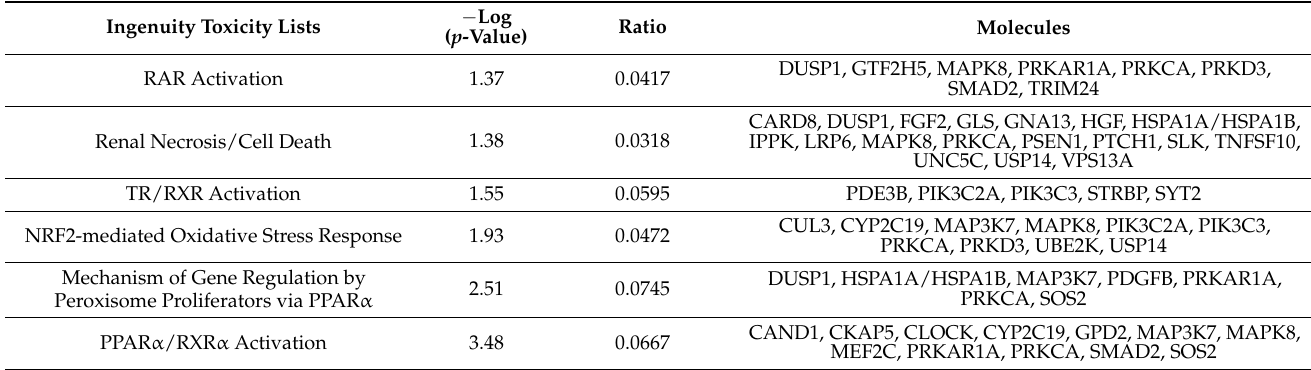
Table 2. Tox list of the predicted target genes of miR-545-3p according to the IPA